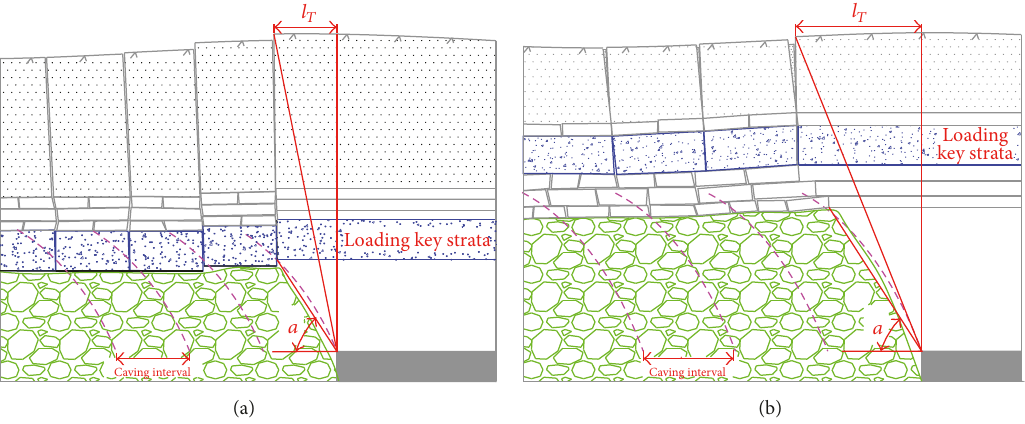
Figure 12: Periodic movement of loading key strata and formation of surface